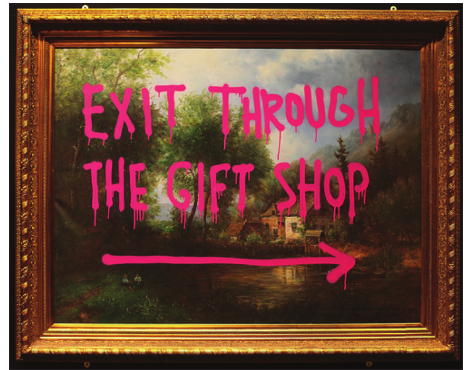
Figure 1: Banksy: Exit through the gift shop (Reproduced with permission of Pest Control acting on behalf of the